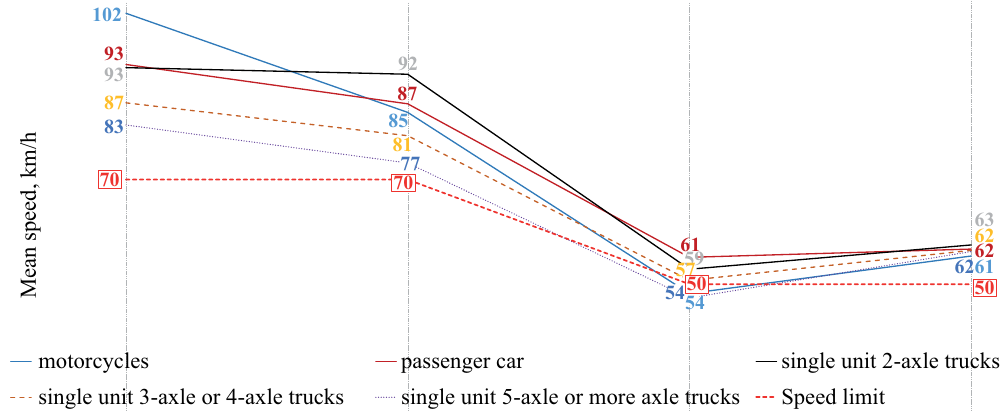
Figure 3. Speed distribution according to vehicle